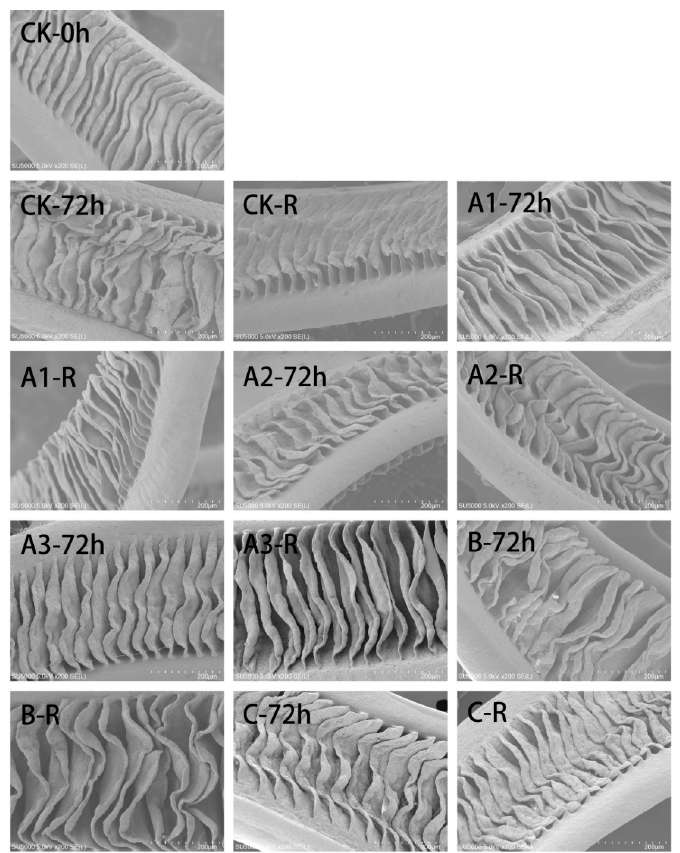
Figure 2. Representative scanning electron micrographs of gill structure. The groups represented by different letters and numbers are the same as in Figure 1.